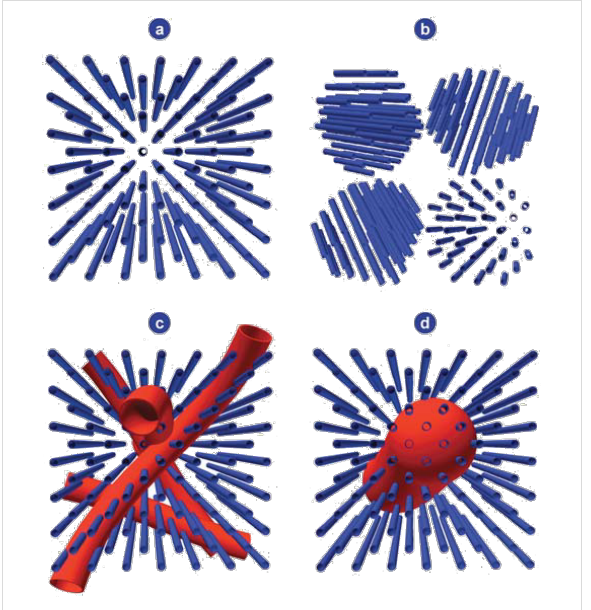
Figure 1: Different degrees and types of hierarchy can be defined in porous materials [48]. Reproduced by permission of The Royal Society of